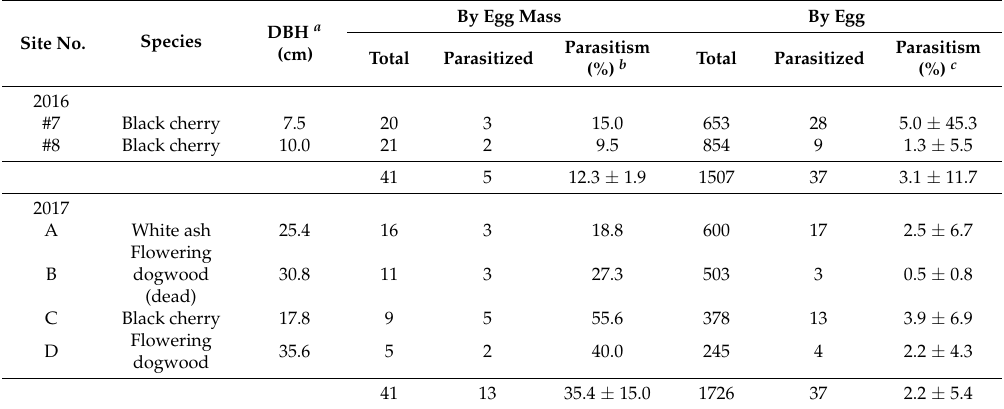
Table 2. O. kuvanae parasitism on L. delicatula eggs by oviposition site at plot ODSouth based on laboratory incubation (2016) and field observation